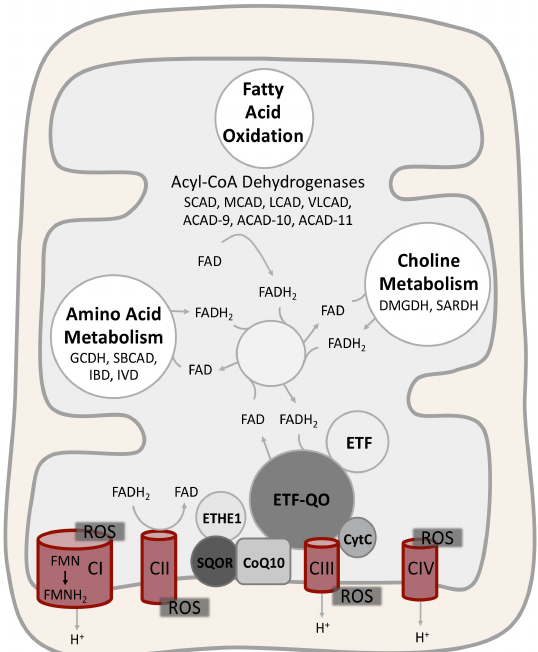
Figure 2. Disease-related flavoenzymes in mitochondrial energy metabolism. Several flavoenzymes are involved in the mitochondrial energy metabolism including fatty acid oxidation, amino acid metabolism and choline metabolism. Acyl-CoA dehydrogenases are involved in fatty acid oxidation and amino acid metabolism, while dimethylglycine dehydrogenase (DMGDH) and sarcosine dehydrogenase (SARDH) participate in choline metabolism. All these dehydrogenases harbor FAD as a redox cofactor, which is reduced to FADH 2 during the dehydrogenation reactions. The dehydrogenases donate the electrons obtained from their substrates to the electron transfer flavoprotein (ETF), and finally to the electron transport chain (ETC) through the ETF-ubiquinone oxidoreductase (ETF-QO), which reduces coenzyme Q10 (CoQ10). The ethylmalonic encephalopathy protein 1 (ETHE1) is connected to the electron transport chain via the sulfide:quinone oxidoreductase (SQOR) and donates electrons to CoQ10. In the assembly and function of complex I and complex II, FMN and FAD, respectively, have important functions. Additionally, both FMN and FAD are crucial for folding and stability of all these flavoenzymes, that, in some cases, explains the benefits of riboflavin supplementation in patients with genetic variants causing primary or secondary dysfunction of flavoenzymes. Riboflavin can also compensate secondary flavin homeostasis